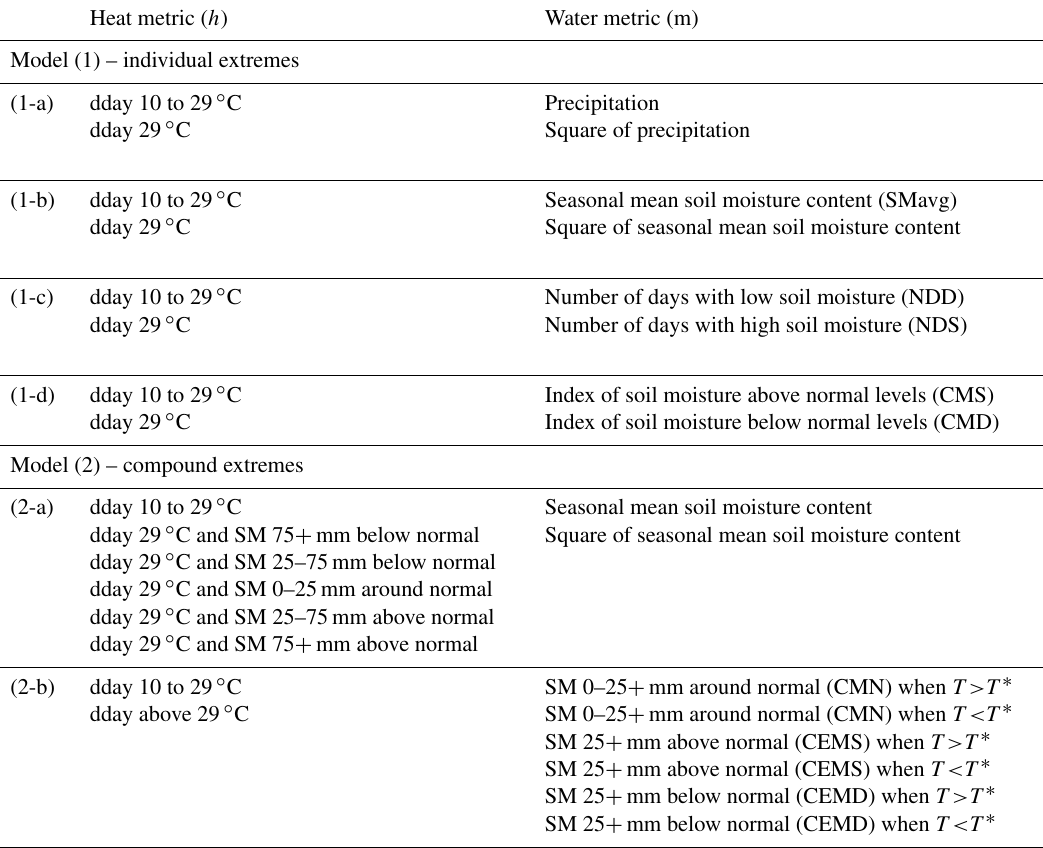
Table 1. Major variables in each model of the